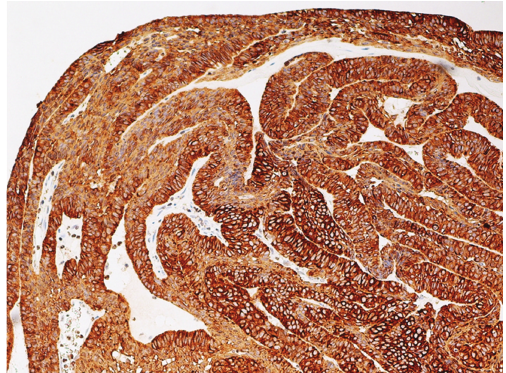
Figure 5: Neoplastic cells showing a di ff use immunostaining with CK